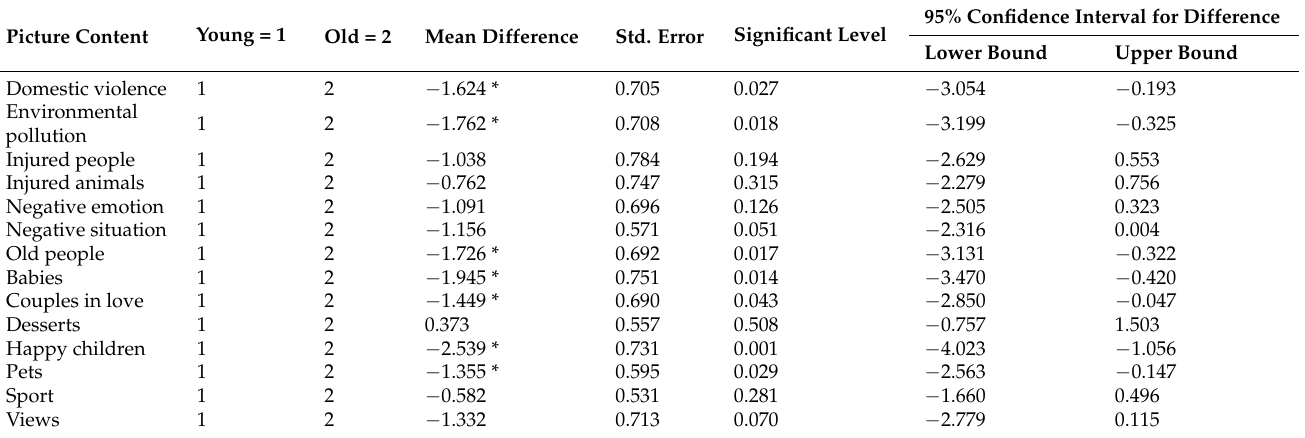
Table A3. Bonferroni pairwise comparisons between picture content and age groups for self-reported physiological arousal.